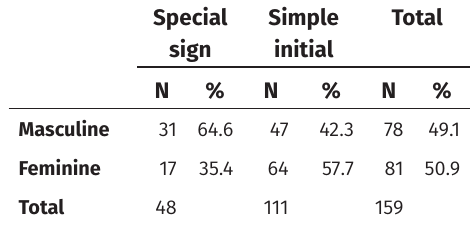
Table 6: Use of the special sign and simple initial according to the sex.